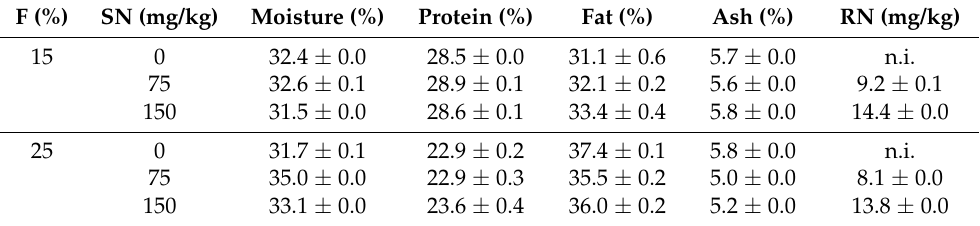
Table 2. Proximate chemical composition and RN content of